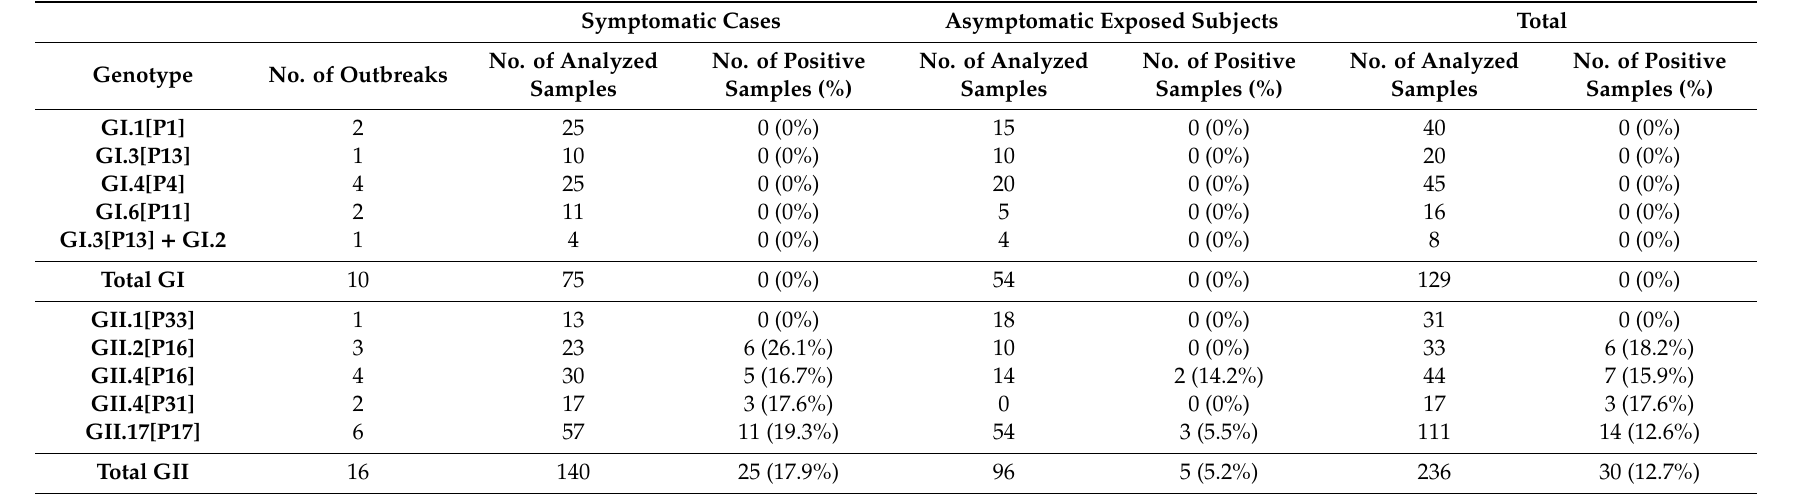
Table 3. Prevalence of HuNoV RNA in saliva samples of studied subjects, according to the genotype to which they were exposed. Symptomatic